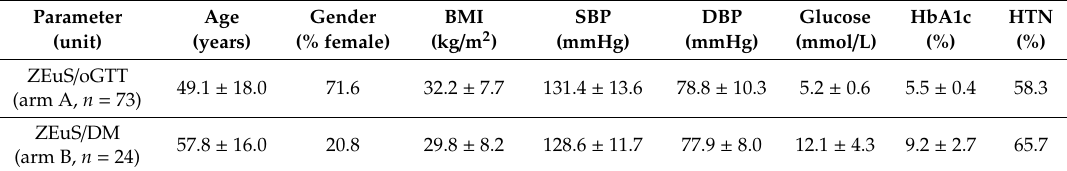
Table 1. Baseline characterization of individuals in the two arms of the ZEuS study. While the portion of female patients was higher in arm A intensivation of insulin therapy was more frequently done in male patients (arm B). The patients in arm A were younger and suffered less frequently from hypertension. Their BMI, however, was higher. Abbreviations: body mass index (BMI), diastolic blood pressure (DBP), diabetes mellitus (DM), hypertension (HTN), oral glucose tolerance test (oGTT), systolic blood pressure (SBP), Zucker, Endothel, und Salz (sugar, endothelium, and salt) study